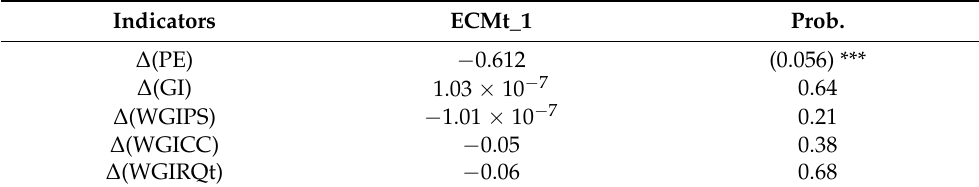
Table 7. The findings of cointegration between the selected parameters in the long run for Ukraine